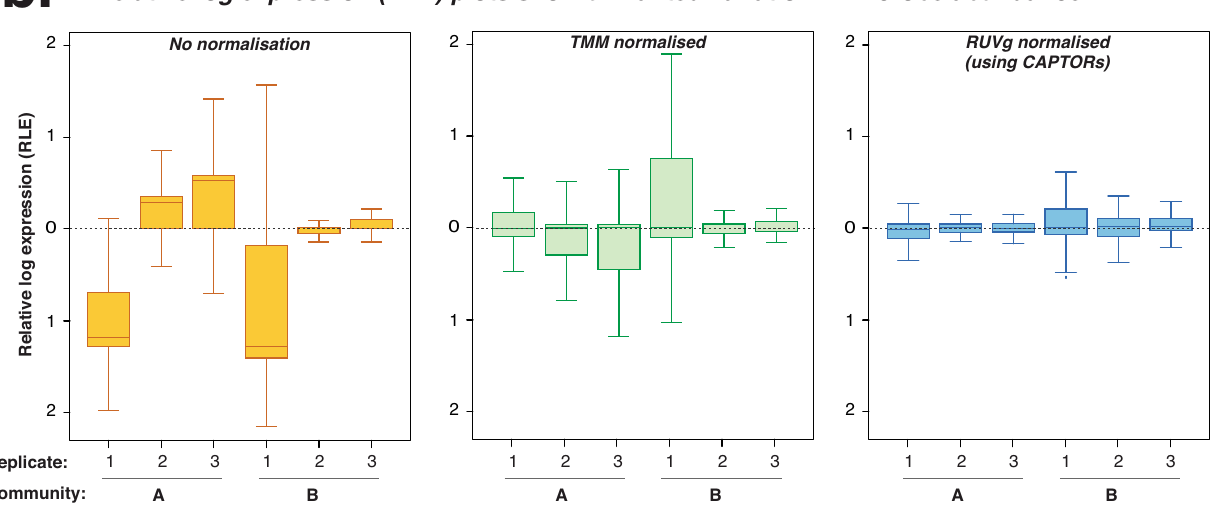
Fig.4 |Measuring fold-changedifferencesbetweensamplesusingquantitative CAPTORs. a Scatter plot compares the expected and observed fold-changes between mock microbial communities with no normalisation, Trimmed Mean of M-values (TMM) normalisation and removal of unwanted variation (RUVg) nor- malisationusing CAPTORs.95%con fi denceintervalsoflineofbest fi